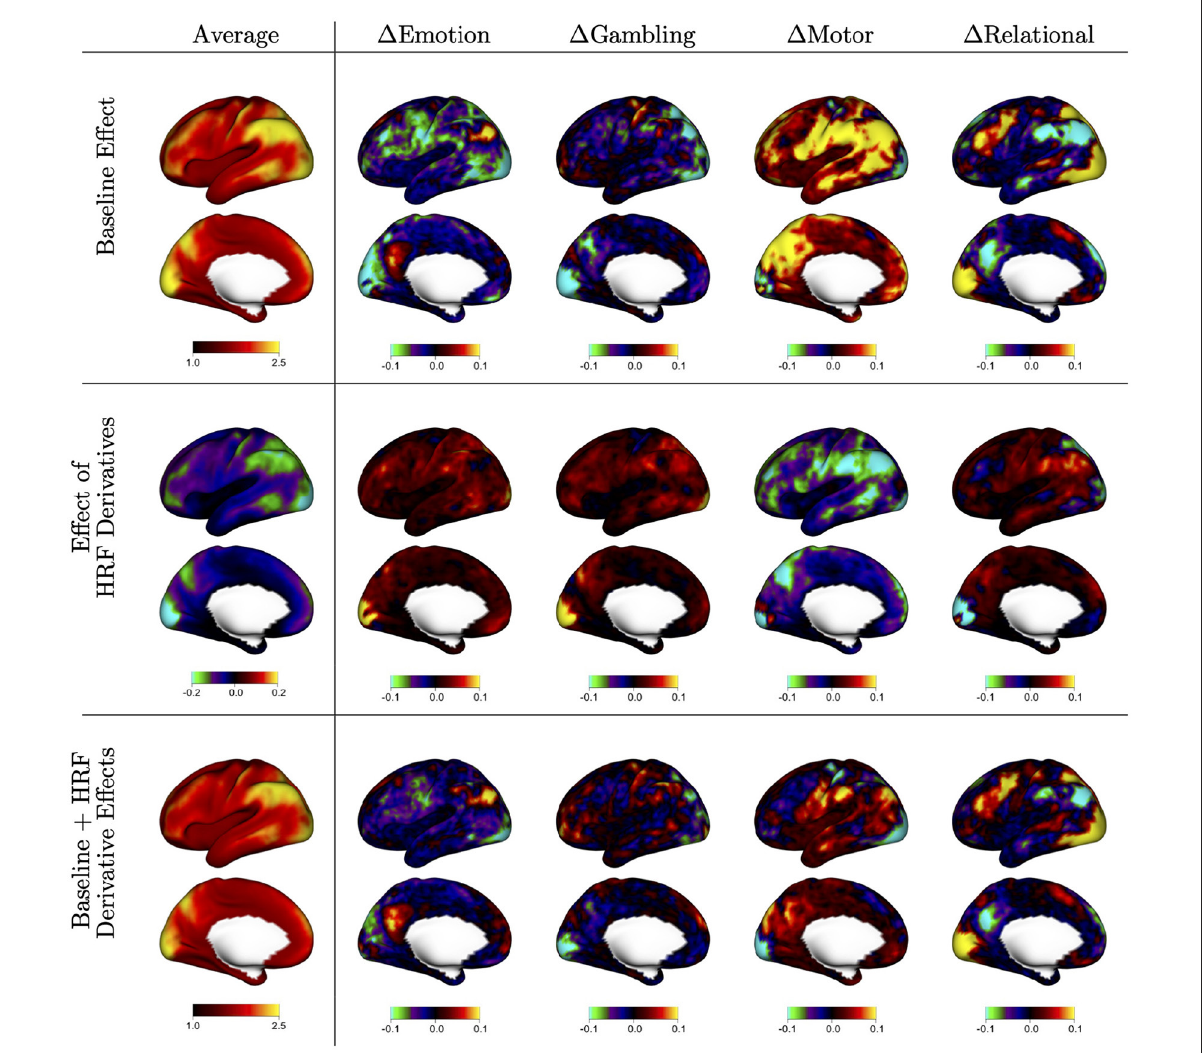
FIGURE2 Baseline autocorrelation index (ACI) and effect of including HRF derivatives by task, based on the fixed effects (FEs) from the mixed effects model shown in equation (2). The first column shows the average of FE estimates across tasks, indicating general spatial patterns of autocorrelation and the effect of HRF derivatives across the cortex. The other columns show the difference between each task and the average, to show areas of stronger or weaker effects during specific tasks. The first row shows the average ACI when assuming a canonical HRF [ α k ( v )]; the second row shows the effect of including HRF derivatives to allow for heterogeneity in the shape of the HRF [ β k ( v )]; the third row shows the sum of both effects, which represents the average ACI when including HRF derivatives in the model [ α k ( v ) + β k ( v )].